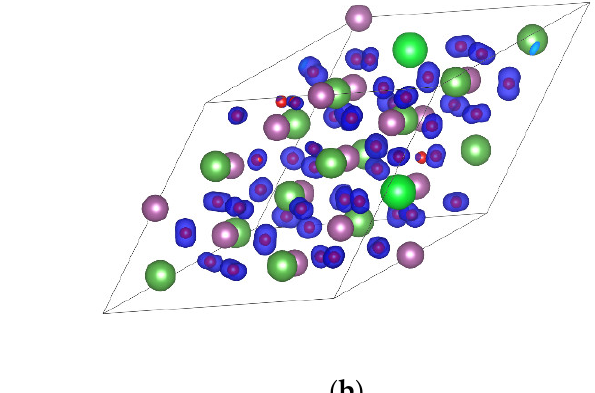
Figure 3. Density of states (DOS) for various combinations of F-type centres, as described in Table 4 and shown in Figure 1. ( a ) 0. ( b ) 0.25. ( c ) 0.5. ( d ) 0.75. ( e ) 1. ( f ) 1.25. ( g ) 1.5. ( h ) 1.75. ( i ) 2.